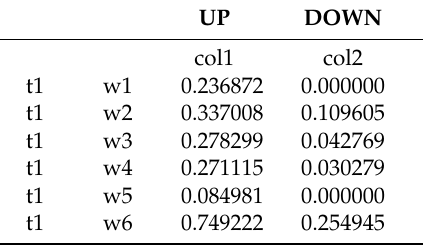
Table A23. Lower and upper bound of wind production: wind_robust_pu_1( t , w ,robust) per unit